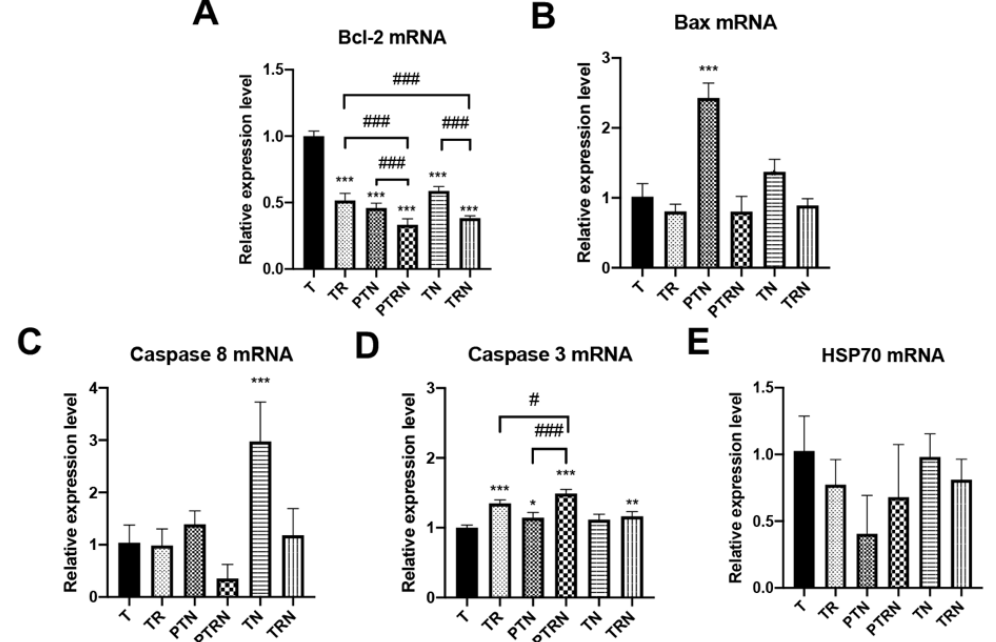
Figure 3. Total nutrition formula upregulates apoptosis in tumors receiving radiotherapy. Relative expression levels of ( A ) Bcl-2, ( B ) Bax, ( C ) caspase 8, ( D ) caspase 3, and ( E ) HSP70 RNAs in the inoculated tumor were measured by RT-PCR ( n = 6). Data are expressed as means ± SD. *, p < 0.05 as compared to the T group. **, p < 0.01 as compared to the T group. ***, p < 0.001 as compared to the T group. #, p < 0.05 as compared between two groups. ###, p < 0.001 as compared between two groups.